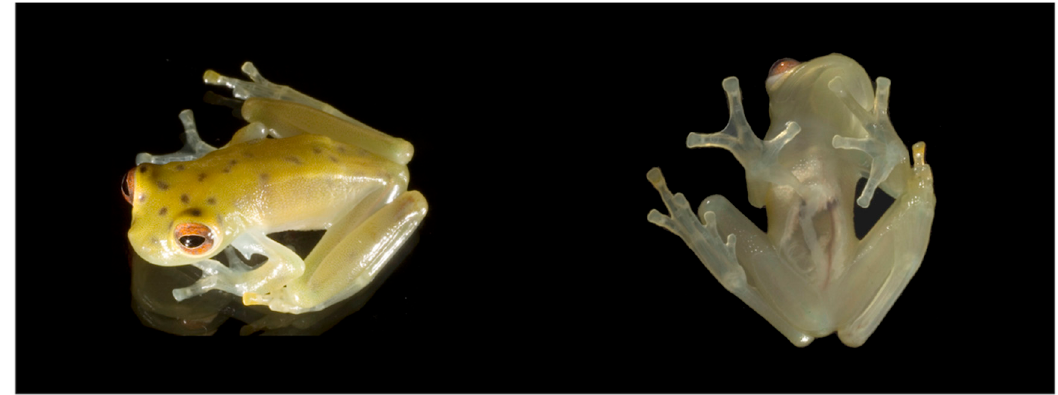
Figure 70. Cochranella litoralis in life. Adult male, QCAZ 27693, from near Durango, 220 m, Esmeraldas province, Ecuador. Photos by Luis A. Coloma.